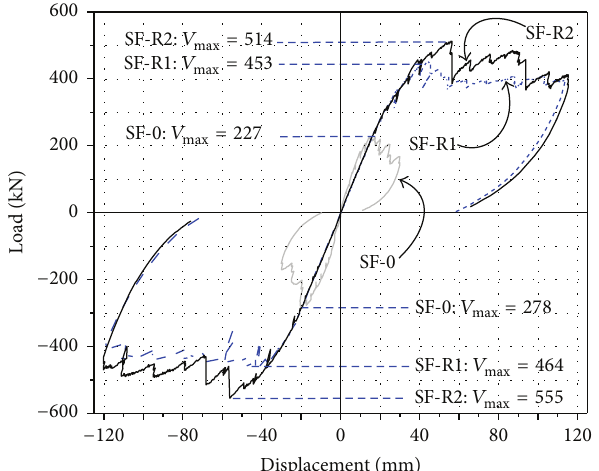
Figure 13: Envelop curves for lateral load-displacement relations of all